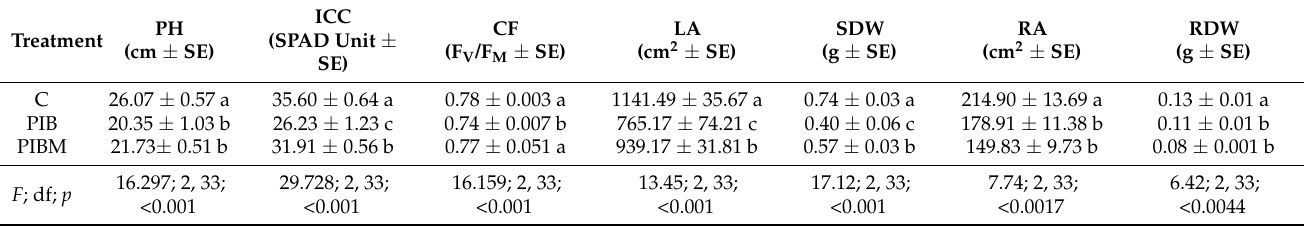
ANOVA parameters are reported for each test condition. Within each column, data followed by different letters